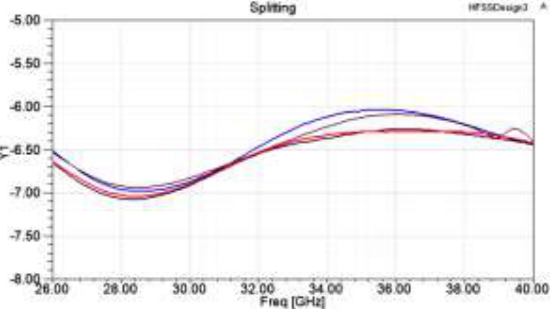
Figure 6: The perfect splitting on the quadruple innovative